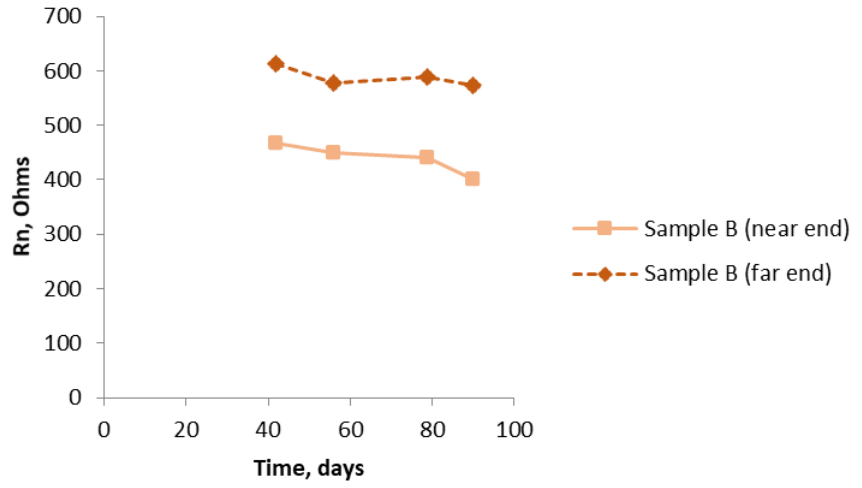
Figure 10. R n results for Sample B (near end 4% Cl, far end 0% chloride) using the bridge arrange- ment.